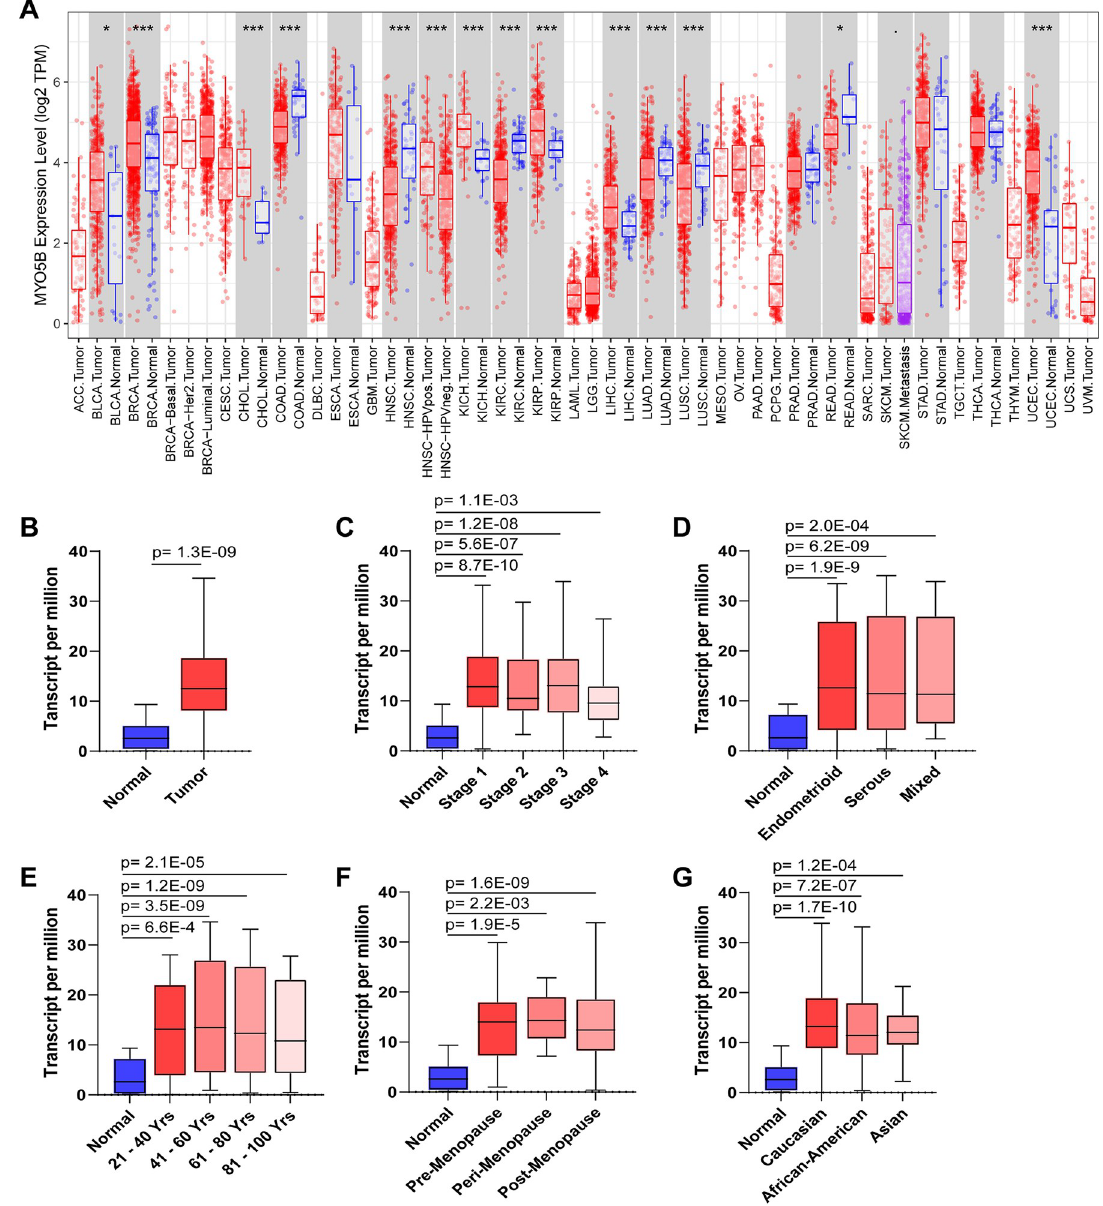
Fig 1. MYO5B mRNA is elevated in uterine corpus endometrial carcinoma (UCEC) patients. A. The expression of MYO5B in various control tissues and tumor types. � p < 0.05, �� p < 0.001, ��� p < 0.0001. mRNA expression in transcript per million of MYO5B in normal and B. grouped UCEC tumor samples; C. stage 1, 2, 3 and 4 UCEC tumors; D. endometroid, serous, or mixed tumor types; E. patient age; F. menopause status, or patient